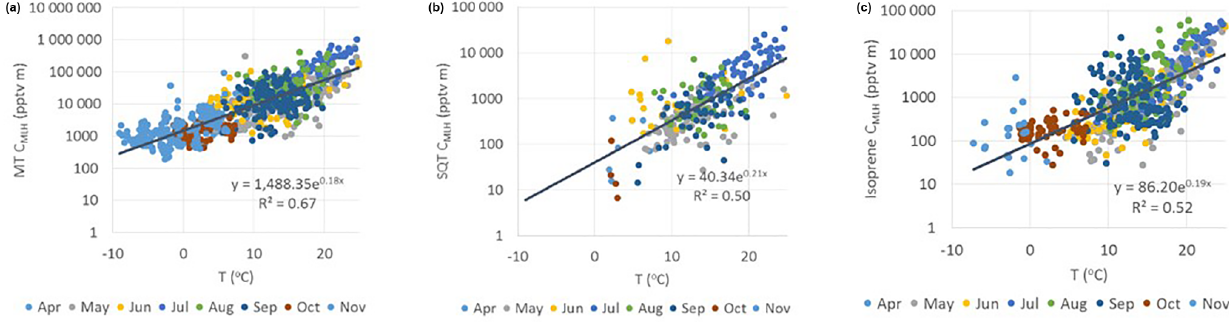
Figure 7. Correlation of temperature with (a) MT, (b) SQT and (c) isoprene concentrations multiplied by the mixing layer height ( C MLH ) measured at the SMEAR II station in 2016. Note that the y axes are in a logarithmic